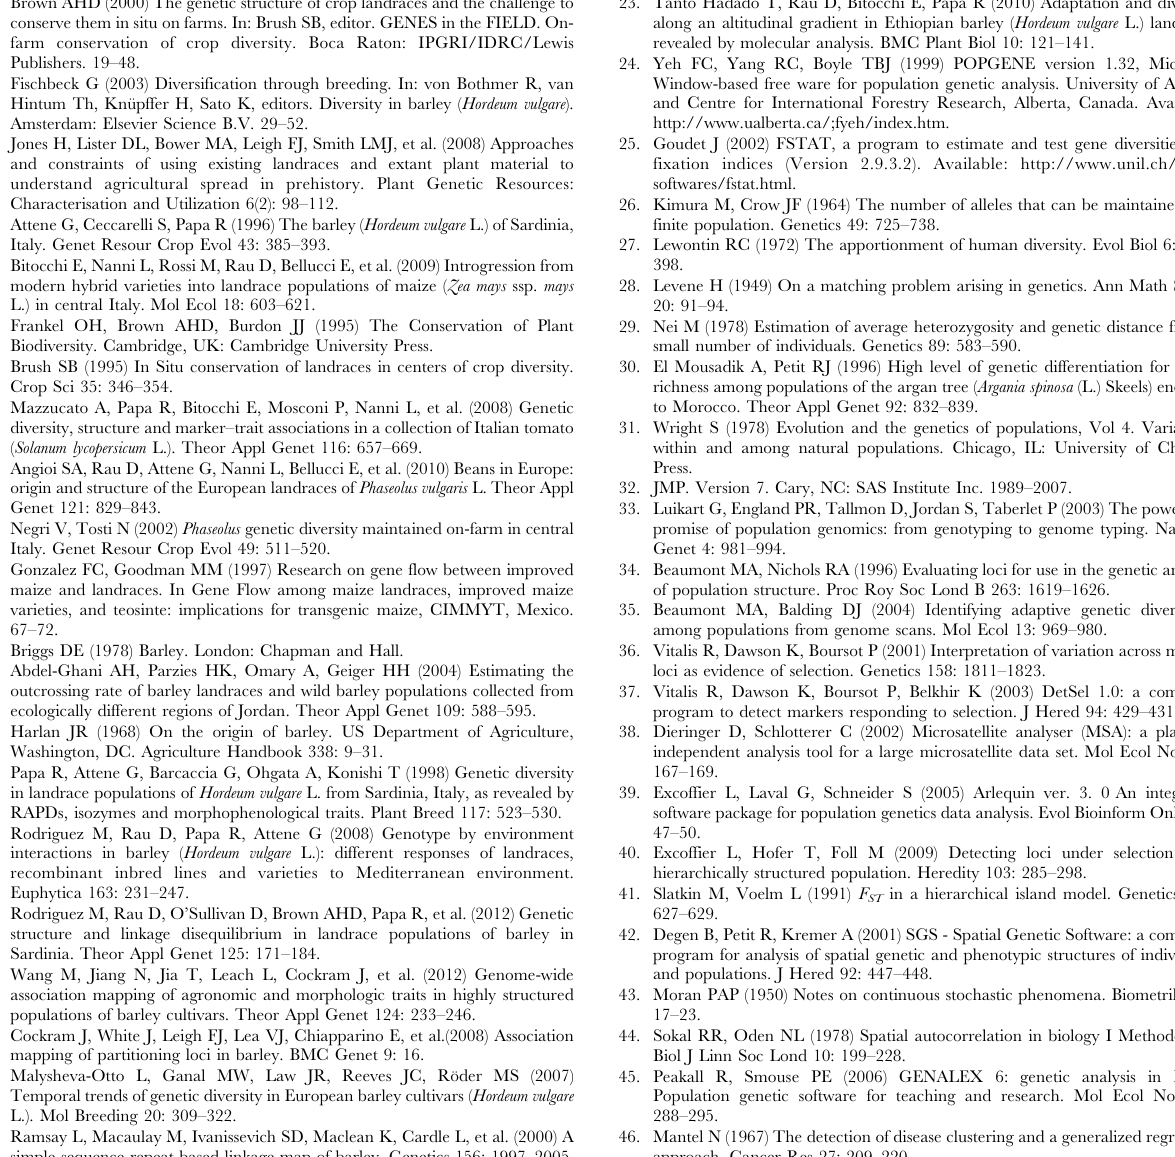
Table S4 Pairwise F ST between SL (SL90, SL99), Var2 and